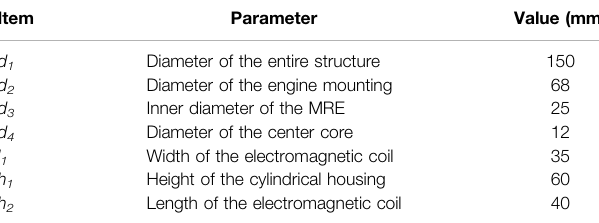
TABLE 1 | Structural parameter of the MRE engine mount structure.